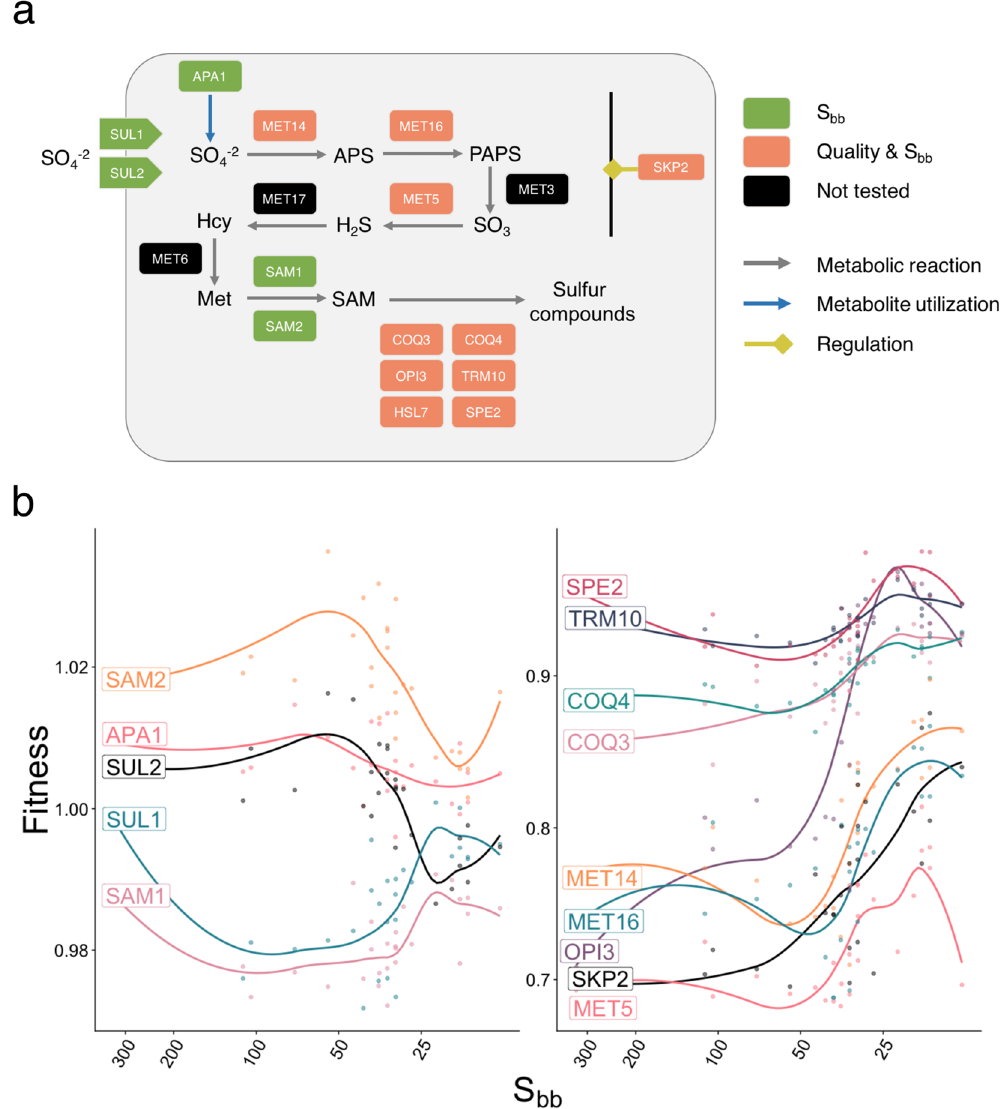
Figure 4. The S. cerevisiae deletion strains annotated as involved in the sulfate metabolic pathway and its regulation are enriched in the S bb and quality lists. ( a ) Schematic representation of the sulfate metabolic pathway. APS: Adenosine phosphosulfate; PAPS: Phosphoadenosine phosphosulfate; SAM; S-adenosyl-L- methionine; Met: Methionine; Hcy: Homocystein. ( b ) The detailed fitness effect of each gene deletion in relation to the Sbb index of maple samples. SUL1 and SUL2 gene deletion strains present opposite fitness as they are low- and high-affinity sulfate transporter, respectively. Line represent the loess regression curve between the fitness and the S bb